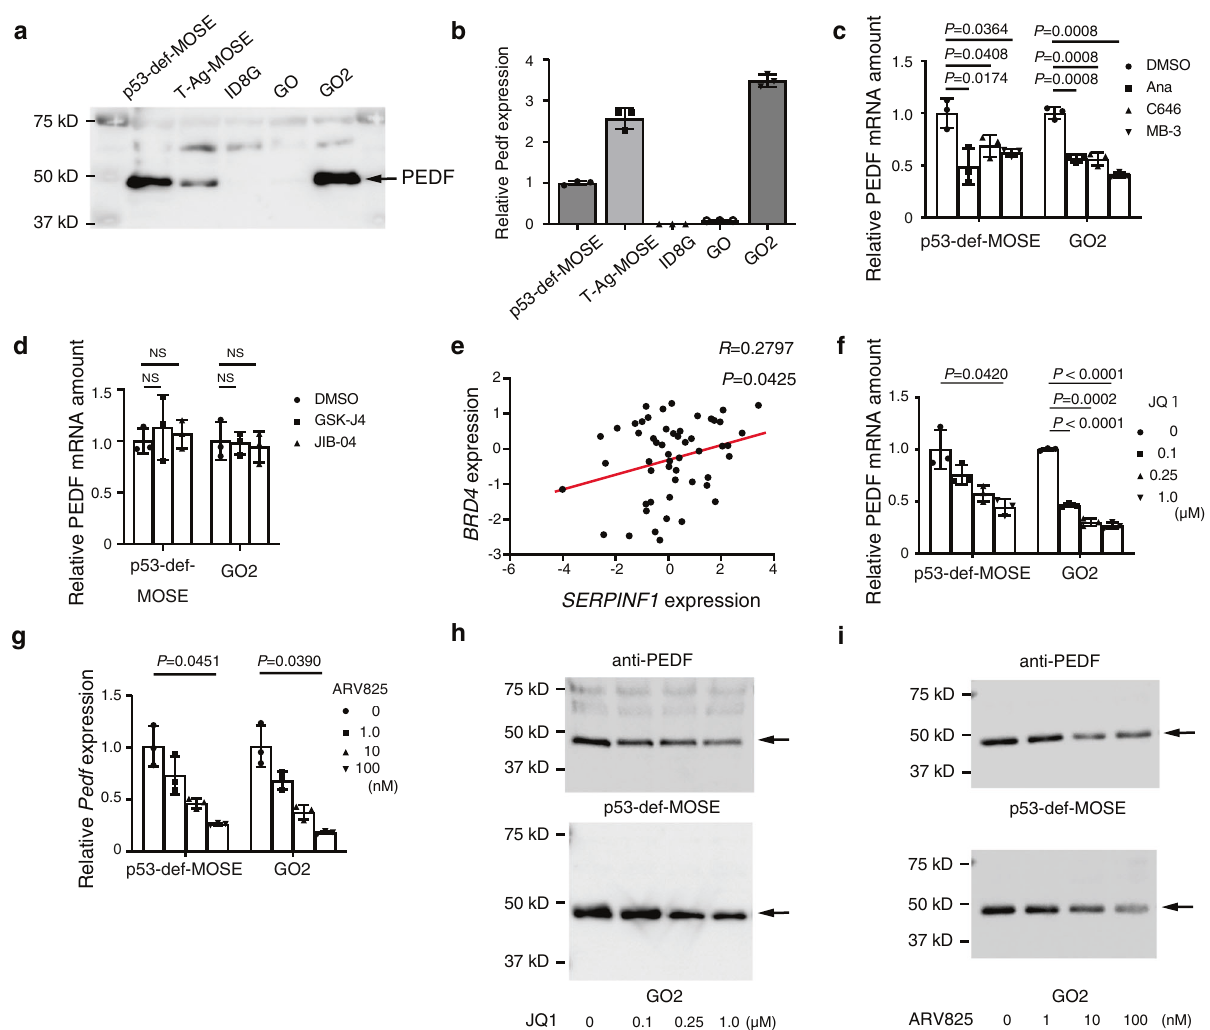
Fig. 7 HAT inhibitors and BET inhibitors suppress PEDF expression in vitro. a Immunoblot analysis of PEDF in culture supernatants of MOSEC, ID8G, GO, and GO2 cell lines. b RT-qPCR analysis of PEDF mRNA in cells as in a . c , d RT-qPCR analysis of PEDF mRNA in p53-def-MOSE and GO2 cells treated for 24 h with the HAT inhibitors anacardic acid (Ana, 10 µ M), C646 (10 µ M), or MB-3 (100 µ M) ( c ) or with the histone demethylase inhibitors GSK-J4 (1.0 µ M) or JIB-04 (250 nM) ( d ). Cells treated with DMSO were examined as a vehicle control. e Pearson ’ s correlation analysis for BRD4 and SERPINF1 expression in 53 specimens of high-grade serous OC obtained by laser capture and microdissection 38 . f , g RT-qPCR analysis of PEDF mRNA in p53-def- MOSE and GO2 cells treated for 24 h with the BET inhibitors JQ1 ( f ) or ARV-825 ( g ) at the indicated concentrations. h , i Immunoblot analysis of PEDF in culture supernatants of cells treated as in f and g . All quantitative data are means ± SD of three replicates for representative experiments out of a total of three performed. Data for c , d were analyzed by unpaired t test with Welch ’ s correction. Data for f , g were analyzed by Welch ’ s ANOVA followed by Dunnett ’ s post hoc